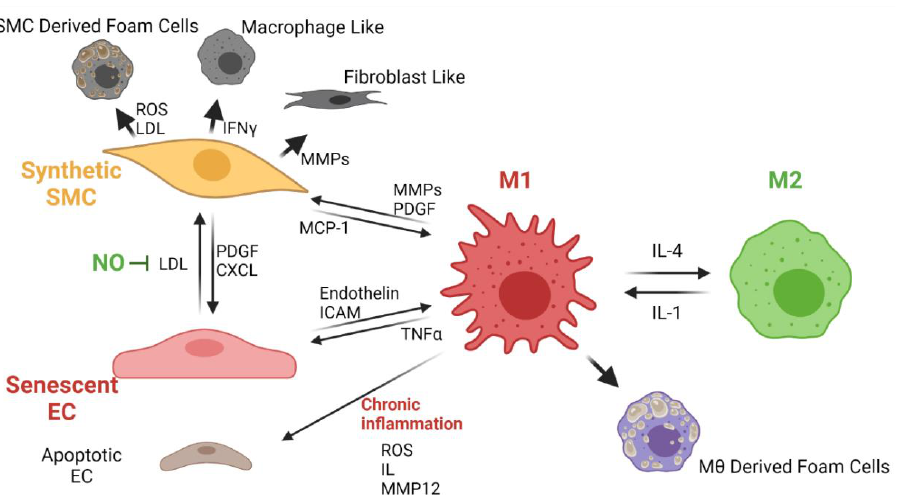
Figure 8. Chronic inflammation and atherosclerosis. If there is resistance of the biomaterial to deg- radation, the oxidative stress produced during inflammation induces changes in the M1 calcium and lipid metabolism. This causes an increase in the intracellular calcium accumulation. Chronic inflammation also induces EC senescence, which is characterized by a decrease in the NO release and an activation of the LDL metabolism. An increase in LDL in addition to the activity of MMPS and PDGF induces a synthetic phenotype of SMCs. This promotes transdifferentiation into SMC derived foam cells, macrophage-like cells or fibroblast-like cells (Created with BioRender.com, ac- cessed on 3 February